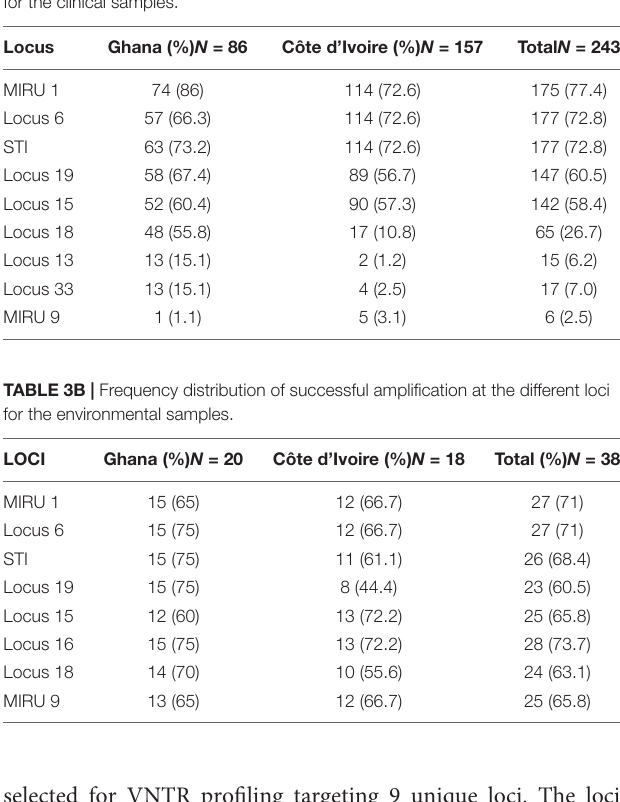
TABLE 4 | Designated genotypes identified with reference studies as